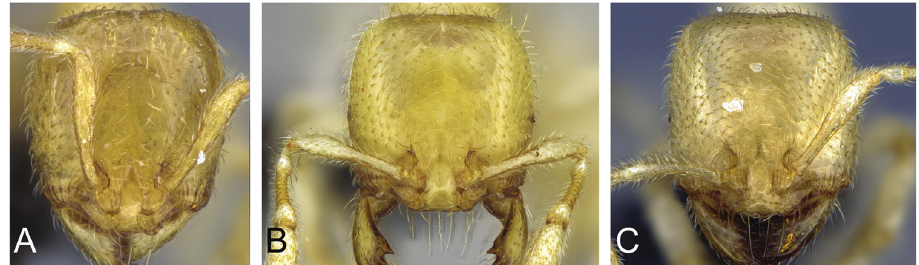
Figure 21. Head in full-face view of A Carebara malagasy (CASENT0044172) B Carebara hiragasy (CASENT0496888) C Carebara placida